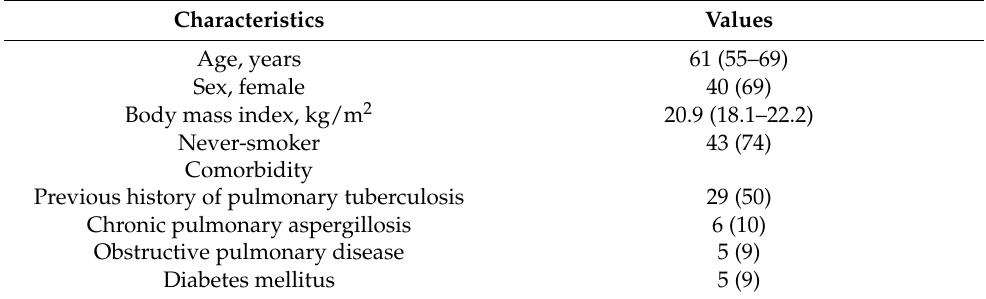
Table 3. Characteristics of patients treated with clofazimine-containing regimens ( n =